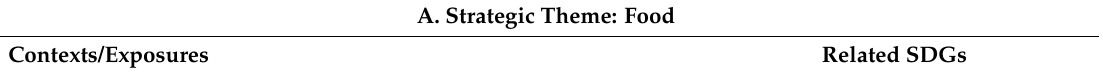
Table 1. Children’s environmental health indicators designed for small island developing states (SIDS)